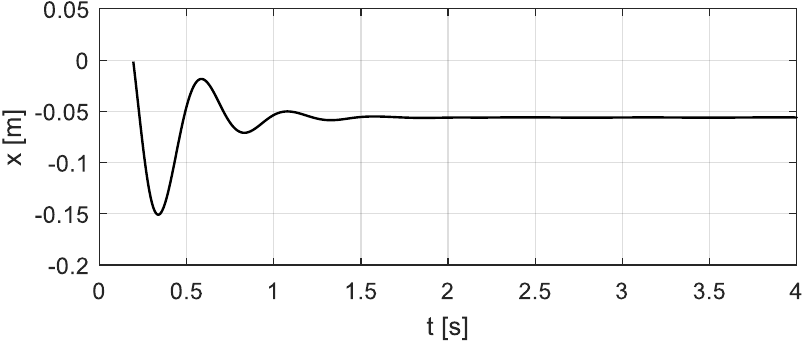
Figure 9. Relative displacement x c ( t ) between the vehicle and the bridge.